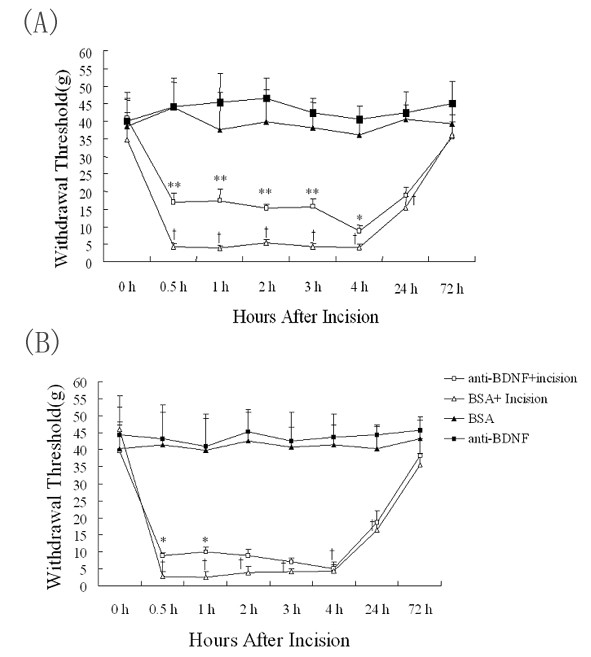
Sequestering spinal BDNF attenuates incision-induced allodynia. Effect of anti-BDNF antibody with IT injection (Figure 6A) or IP administration (Figure 6B) on mechanical withdrawal thresholds (g) after hind-paw incision. Single anti-BDNF antibody IT or IP injection or the saline treatment was performed 1 hour before hind-paw incision. Six to eight rats were used in each group. A, IT injection of anti-BDNF antibody dramatically inhibited the allodynia after hind-paw incision (p < 0.01, two-way repeated measure ANOVA). B, Significant difference was present between IP administration of anti-BDNF antibody (10 mg/kg) and saline treatment. *p < 0.05, group with anti-BDNF IP administration vs control by saline injection; **p < 0.01, group with anti-BDNF IT treatment vs the control by saline injection; † p < 0.01, groups after hind-paw incision vs sham-operated control.